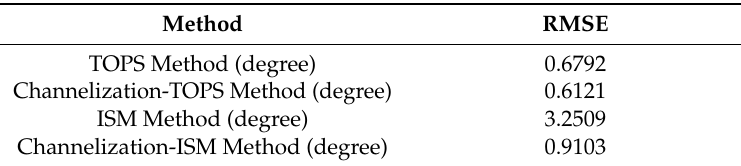
Figure 21. DOA estimations with TOPS method and Channelization-TOPS method. Figure 20. DOA estimations with TOPS method and Channelization-TOPS method. Figure 20. DOA estimations with TOPS method and Channelization-TOPS method. Table 2. Mean deviation of different Table 2. Mean deviation of different methods. Table 2. Mean deviation of different methods.